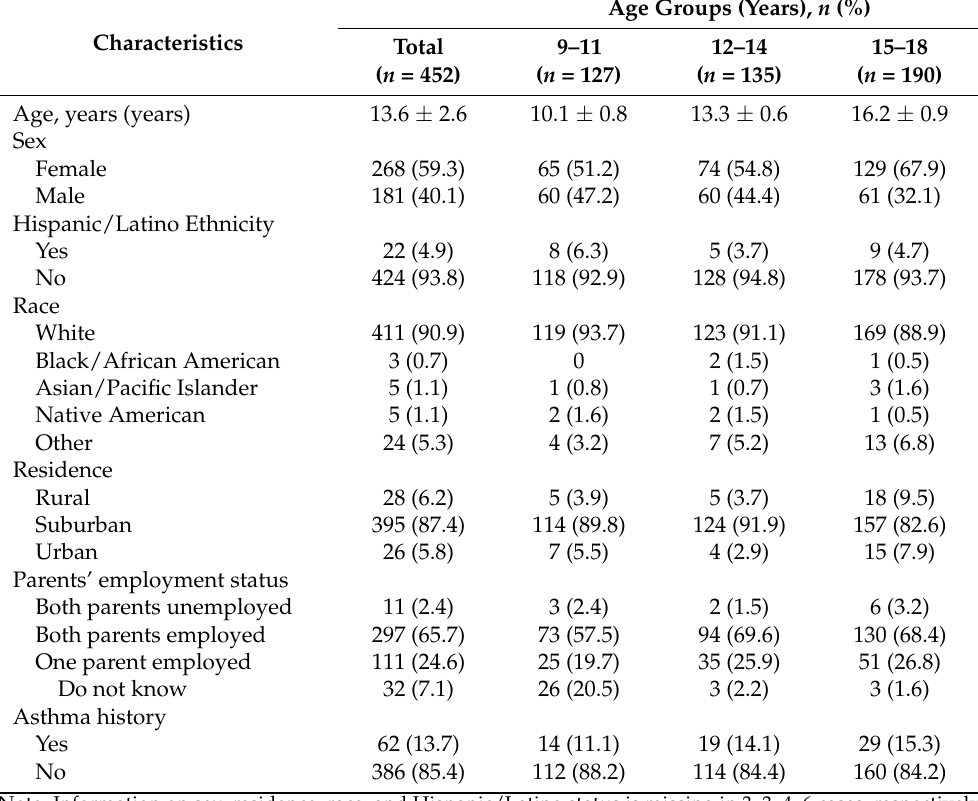
Table 1. Participant